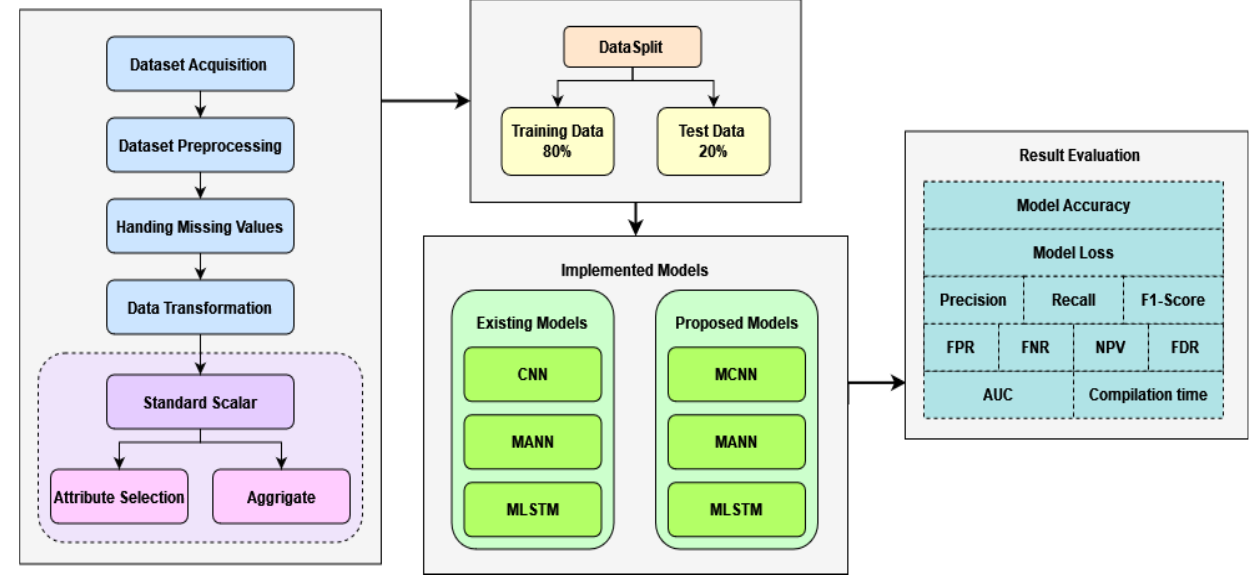
Figure 1. The proposed system architecture for CKD prediction.